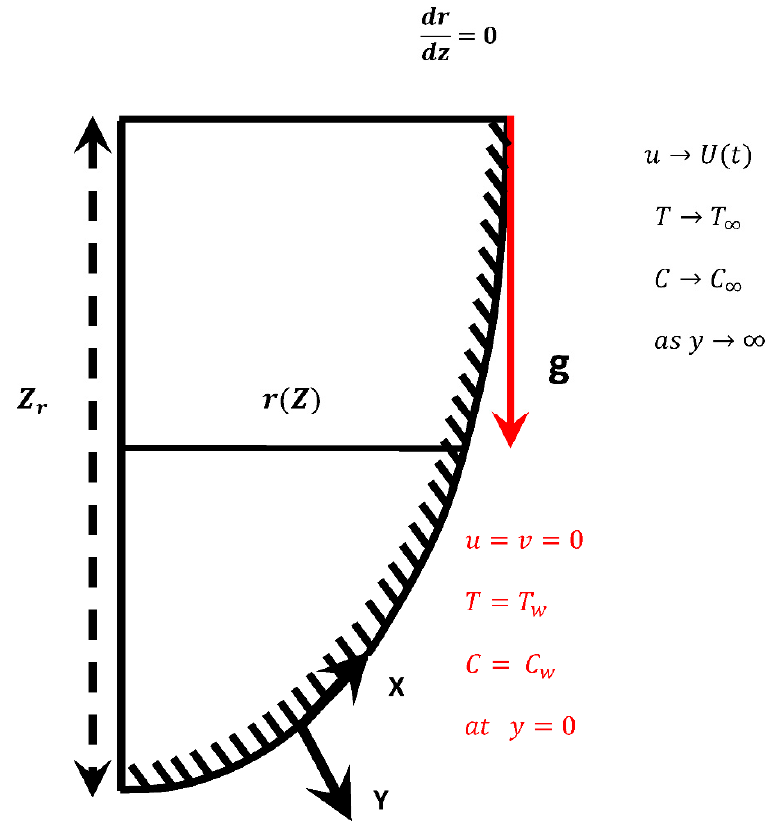
Figure 1. Coordinate system and flow configuration of the proposed model.